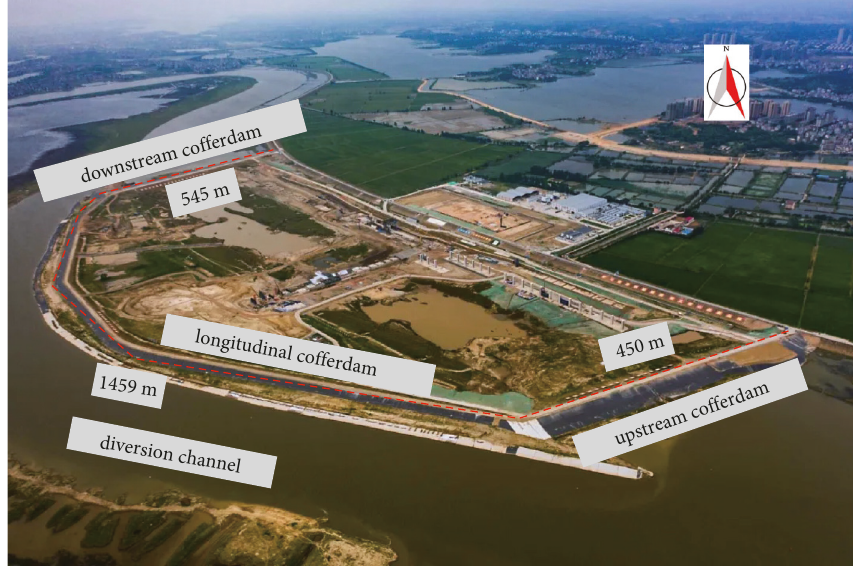
Figure 1: Layout of cofferdam and divert.